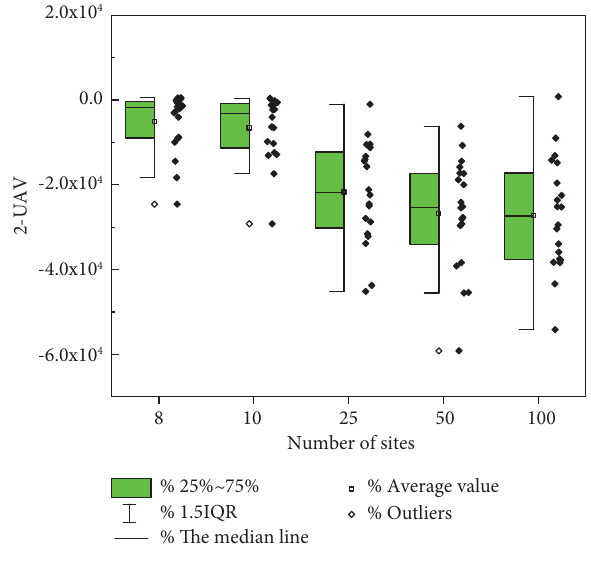
Figure 13: 2-UAVs time saving ratio.